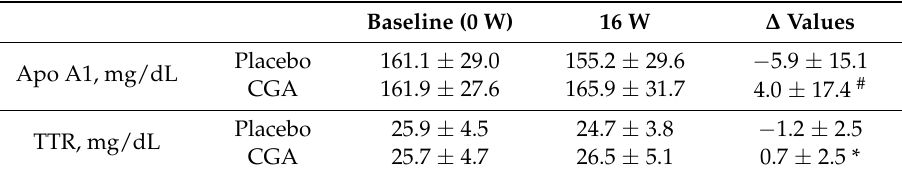
Table 5. Blood concentrations of Apo A1 and